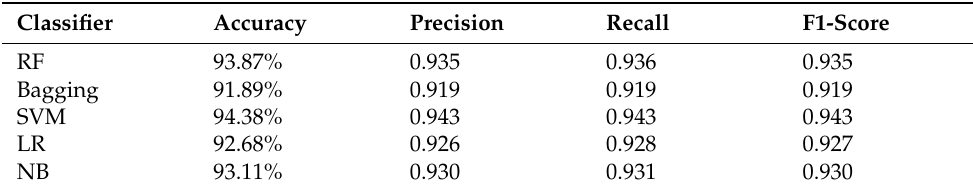
Table 31. Performance results of ML models using the SMOTE dataset and the concatenated features and all lexicons.